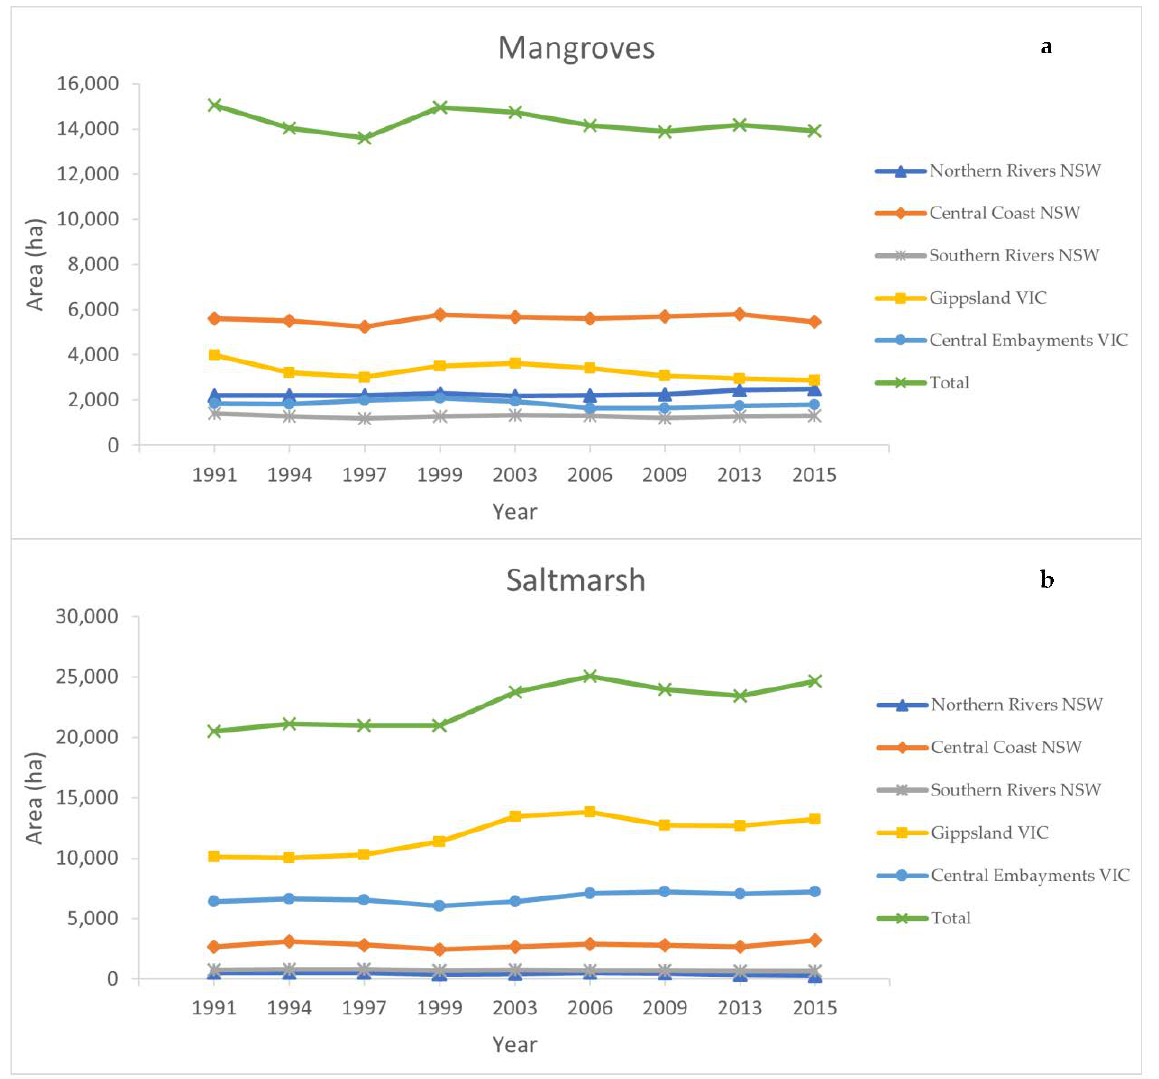
Figure 2. Mangrove ( a ) and saltmarsh ( b ) area extent in ha for every region of interest and in total. The gains, losses, and persistence between 1991 and 2015 of our two classes of interest (mangroves and saltmarsh) across the whole region can be visualised in Figures 3 and 4, respectively, along with several noteworthy zoomed-in examples. Figures 3b and 4b show mangrove extension and saltmarsh loss to water, respectively. Figure 3c shows an example of extensive mangrove declines in Karuah River (Central Coast, NSW), while Figure 4c shows extensive saltmarsh expansion (associated with the rapid saltmarsh increase between 1999 and 2006) in Lake Wellington (Gippsland, VIC). Finally, Figures 3d and 4d show the same area of the northern shore of WesternPort (Central Bays, VIC), where mangroves have lost area to saltmarsh ecosystems while gaining area through